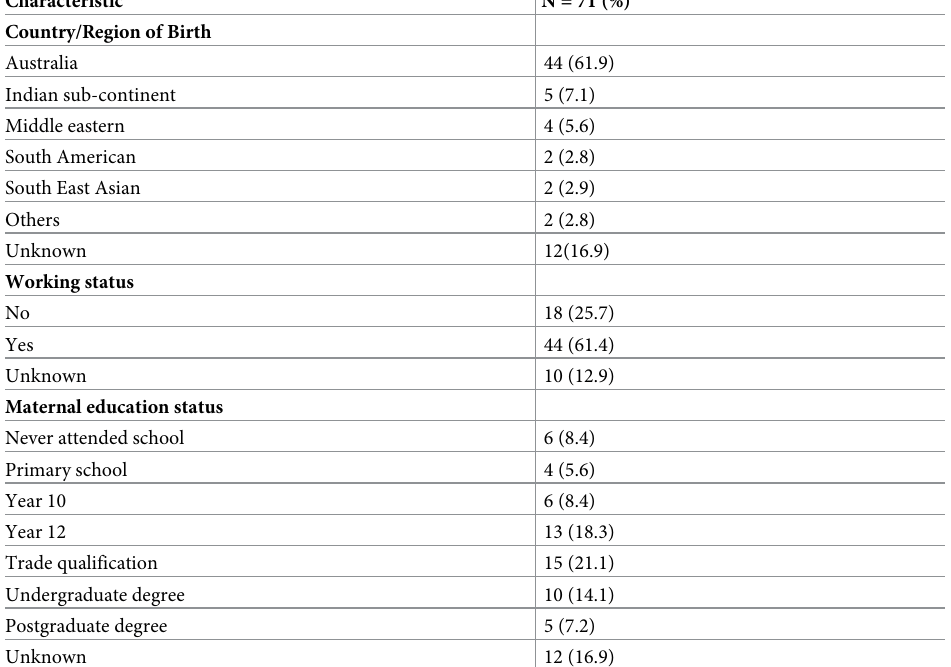
Table 3. Demographic characteristics of mothers.